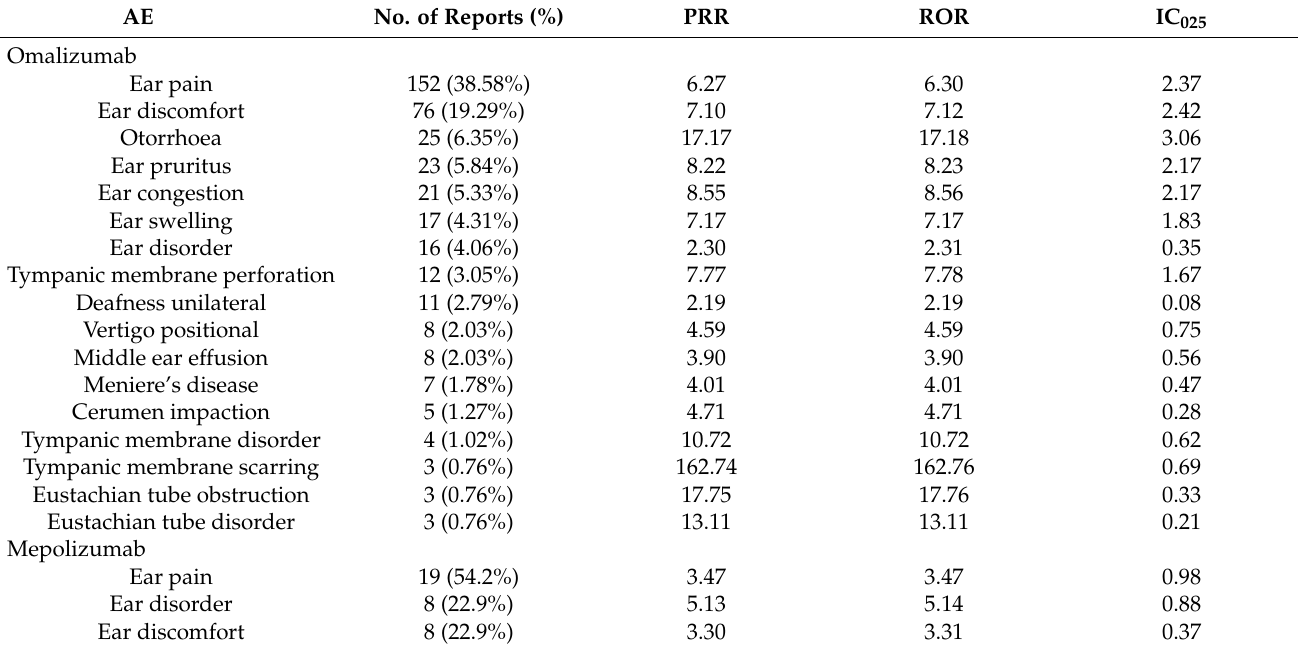
Table 5. Disproportionality analysis results of biologics for asthma related ear and labyrinth disorders.